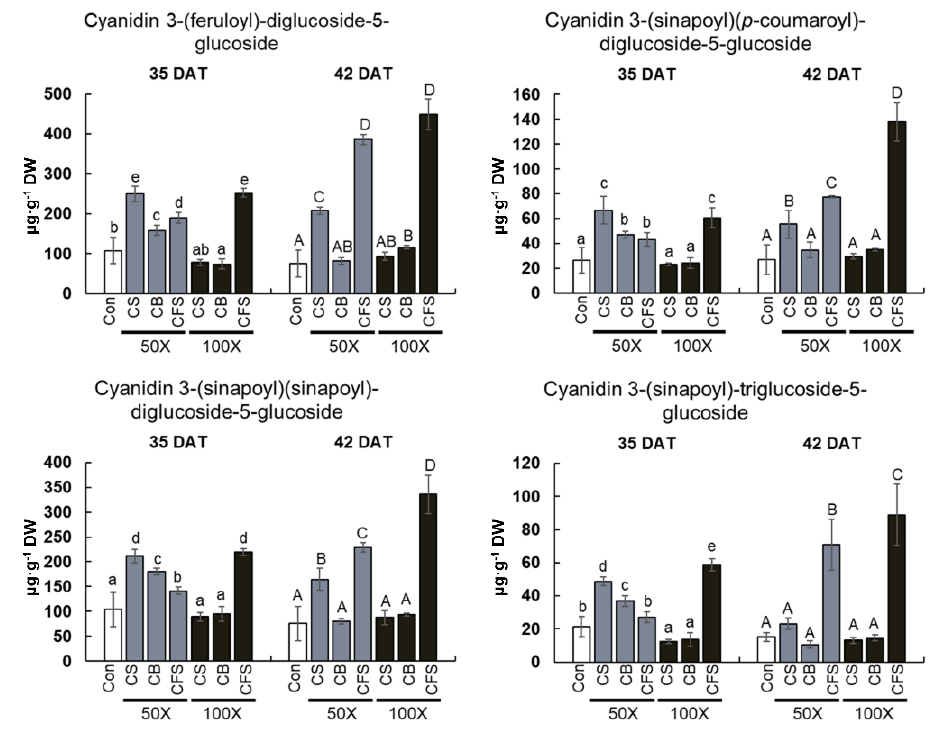
Figure 8. Individual anthocyanin contents ( µ g · g − 1 DW) in “Red Russian” kale after Chlorella treat- ments. Bars represent the mean ± standard deviation of three replicates. Different letters indicate significant differences at p < 0.05 based on Duncan’s multiple range tests. Con, distilled water; CS, Chlorella suspension; CB, Chlorella biomass; CFS, Chlorella − free supernatant; and DW, dry weight.